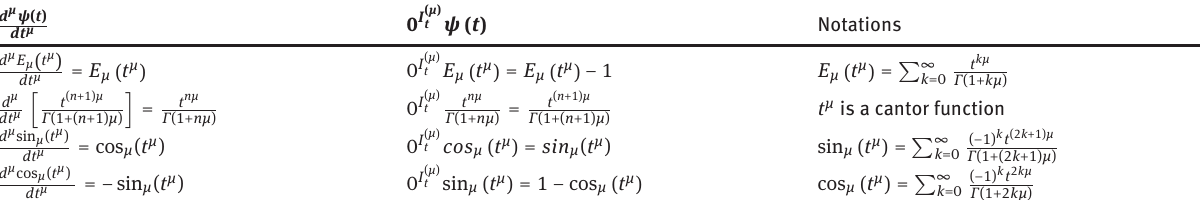
Table 1: List of local fractional derivatives and integrals of some functions d μ ψ ( t ) dt